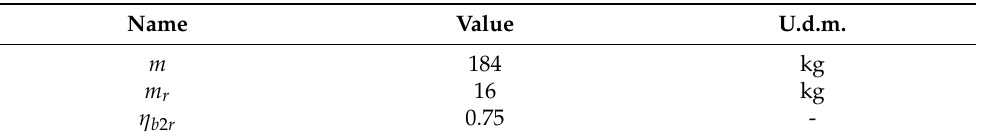
Table 10. Vehicle dynamic model coefficients: m is the sum of the vehicle and driver masses, m r is the value of the equivalent inertia of the rotating components and η b 2 r is the overall battery-to-road efficiency, including the electric motors and transmission losses.